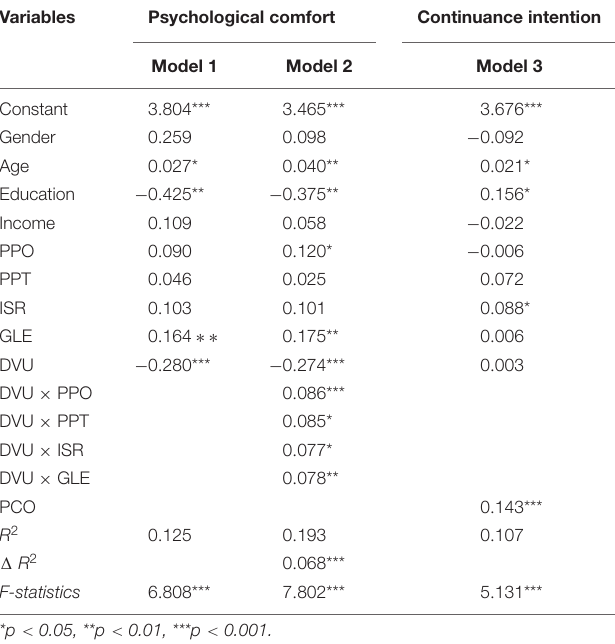
TABLE 4 | Regression results.